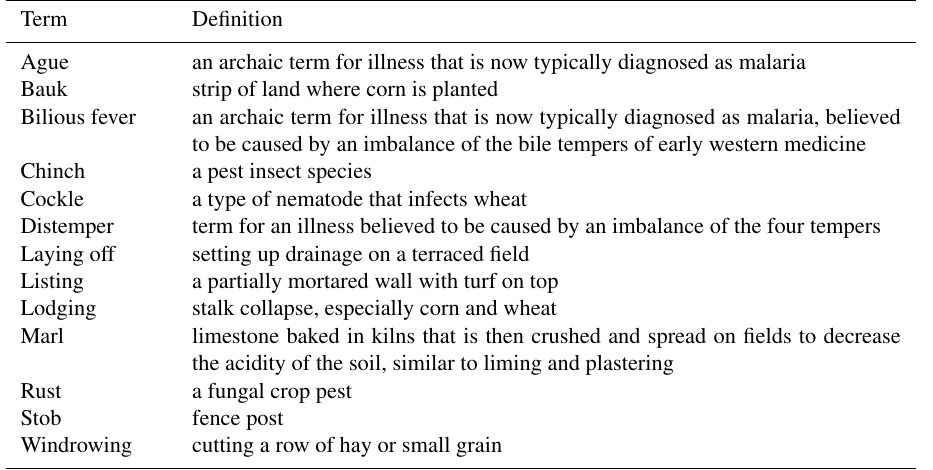
the acidity of the soil, similar to liming and plastering